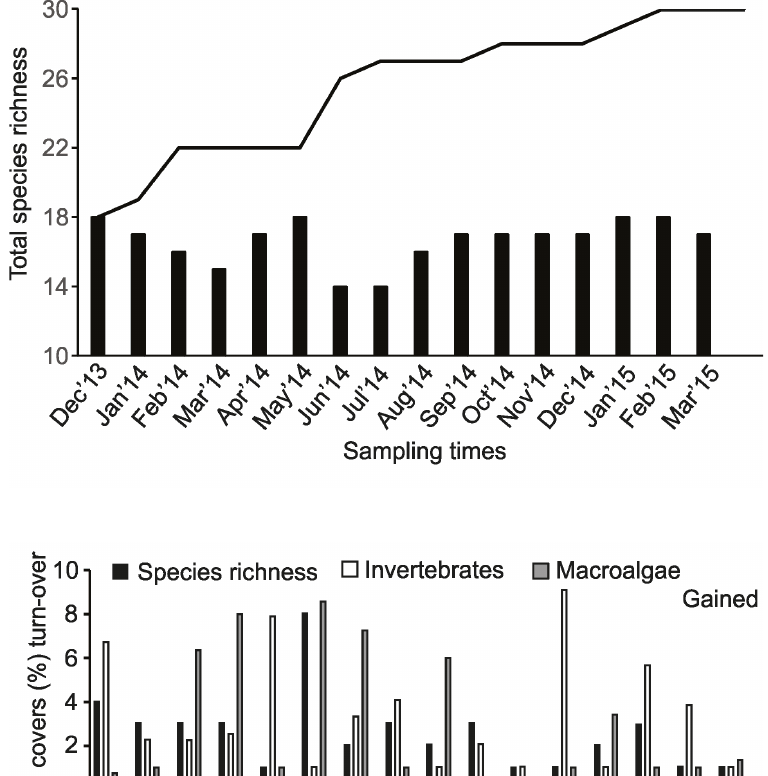
Figure 3. Total number of species found in all six quadrants (0.25 m 2 ) considering a total area analysed of 1.5 m 2 per sampling time (black bars) and cumulative total species richness